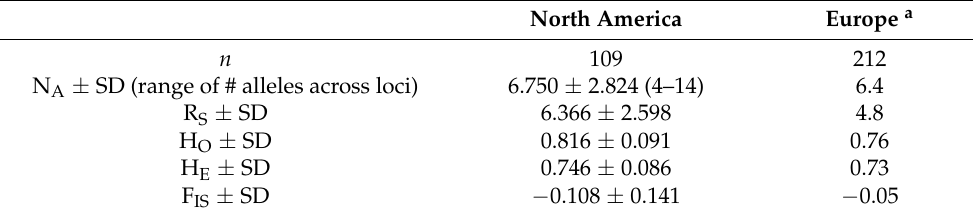
Table 2. Indices of genetic diversity ( ± standard deviation, SD) based on 14 microsatellites amplified in the NA population of APD (this study) and compared to the European captive population [18], which was genotyped at 10 of the 14 microsatellite loci used in the current study. n , sample size; N A , mean number of alleles per locus; R S , allelic richness; H O , mean observed heterozygosity; H E , mean unbiased expected heterozygosity; F IS , inbreeding coefficient. North America Europe a n